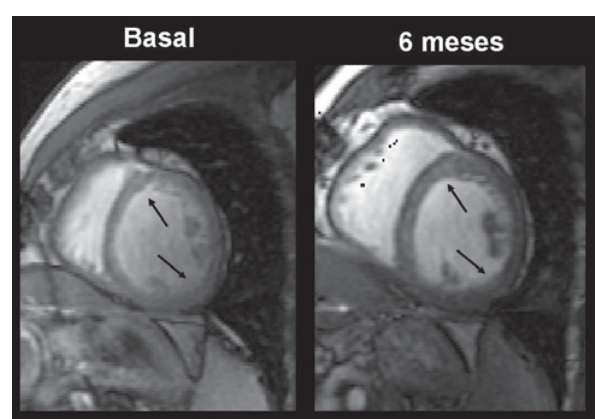
Fig. 4 - Imagens obtidas pela RMC do eixo curto de VE. As setas indicam segmentos miocárdicos com evidente aumento de contratilidade. Nota-se o aumento do espessamento parietal sistólico após o procedimento, comparativamente ao